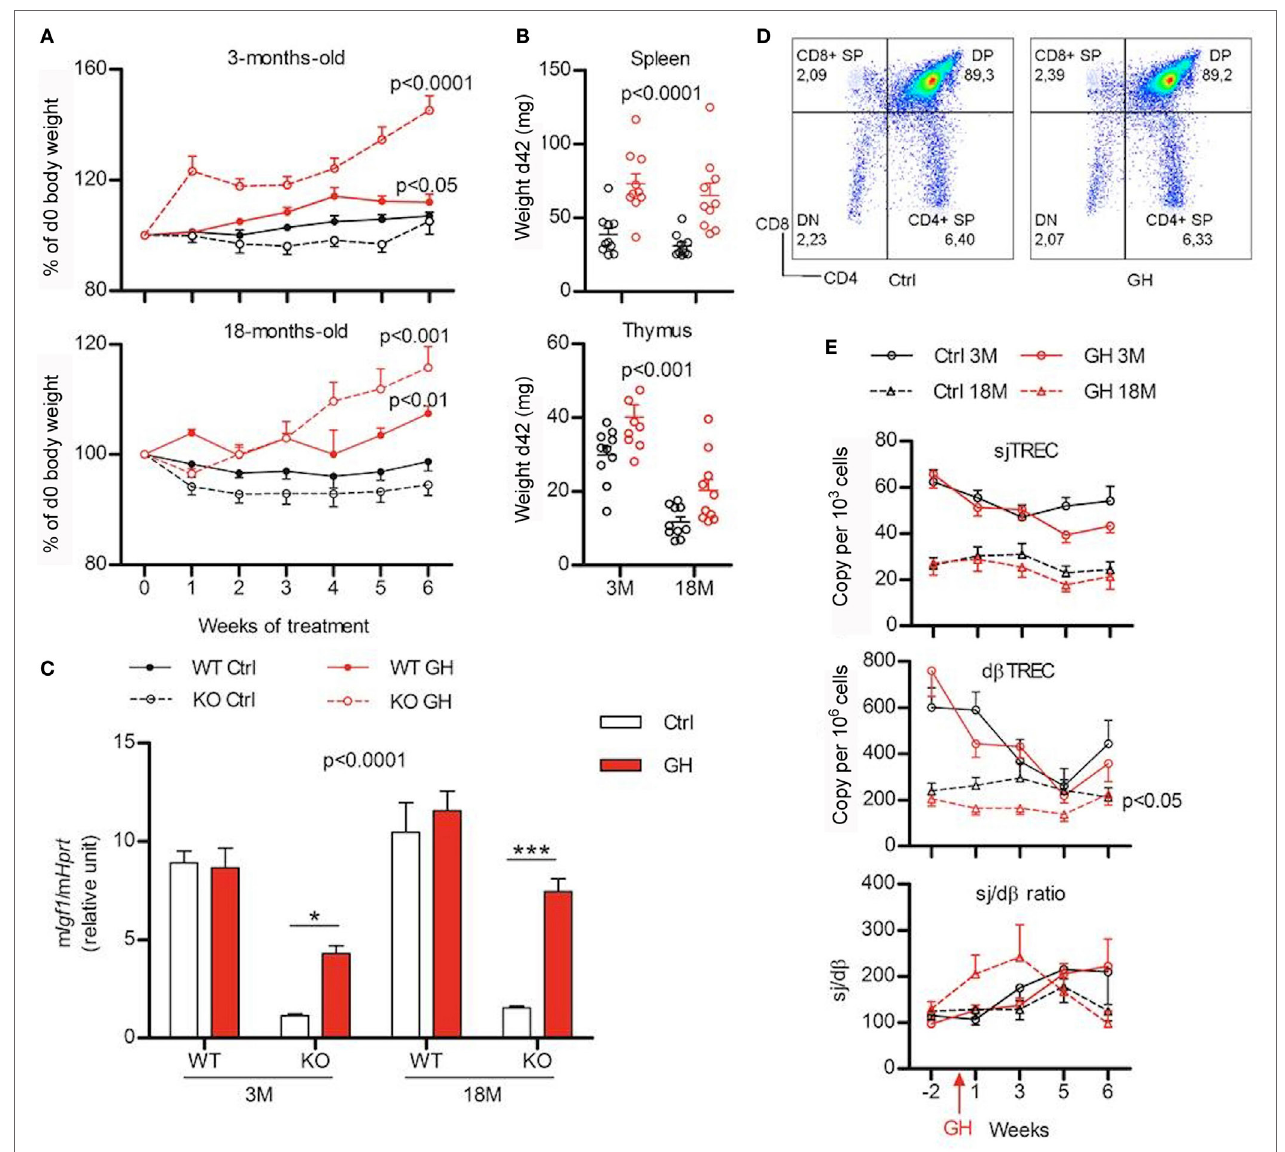
FigUre 3 | Effects of growth hormone (GH) supplementation (6 weeks) on metabolic and immune parameters. (a) Weight variations expressed in percentage of starting value (weight at d0) are shown for 3- (above) and 18-month (below) old wild-type (WT) (filled line) and KO mice (dotted line) injected with GH (red) or control Dulbecco’s phosphate-buffered saline (black). Two-way ANOVA test (time and treatment) was used for statistical analyses ( n = 7–10 per group). (B) Igf1 expression in the liver of KO and WT mice after 6 weeks of GH (red) or control (white) treatment was measured by real-time quantitative PCR and normalized to expression of Hprt. Two-way ANOVA test (treatment and strain) with Bonferroni post-test were used for statistical analyses ( n = 6–10 per group). *** p < 0.001, * p < 0.05. (c) Absolute weight of spleen (above) and thymus (below) of young and old KO mice after 6 weeks of GH (red) or control (black) treatment. Two-way ANOVA test (treatment and age) was used for statistical analyses ( n = 10 per group). (D) Representative flow cytometry plots of immunophenotyping of thymus from control- and GH-injected mouse. (e) Variations of peripheral sjTREC, d β TREC, and sj/d β ratio during GH supplementation (red) and control (black) in 3- (filled line) and 18-month-old (dotted line) KO mice. Two-way ANOVA test (time and treatment) was used for statistical analyses ( n = 10 per group). (a,B,c,e) Data (mean ± SEM) are representative of two independent